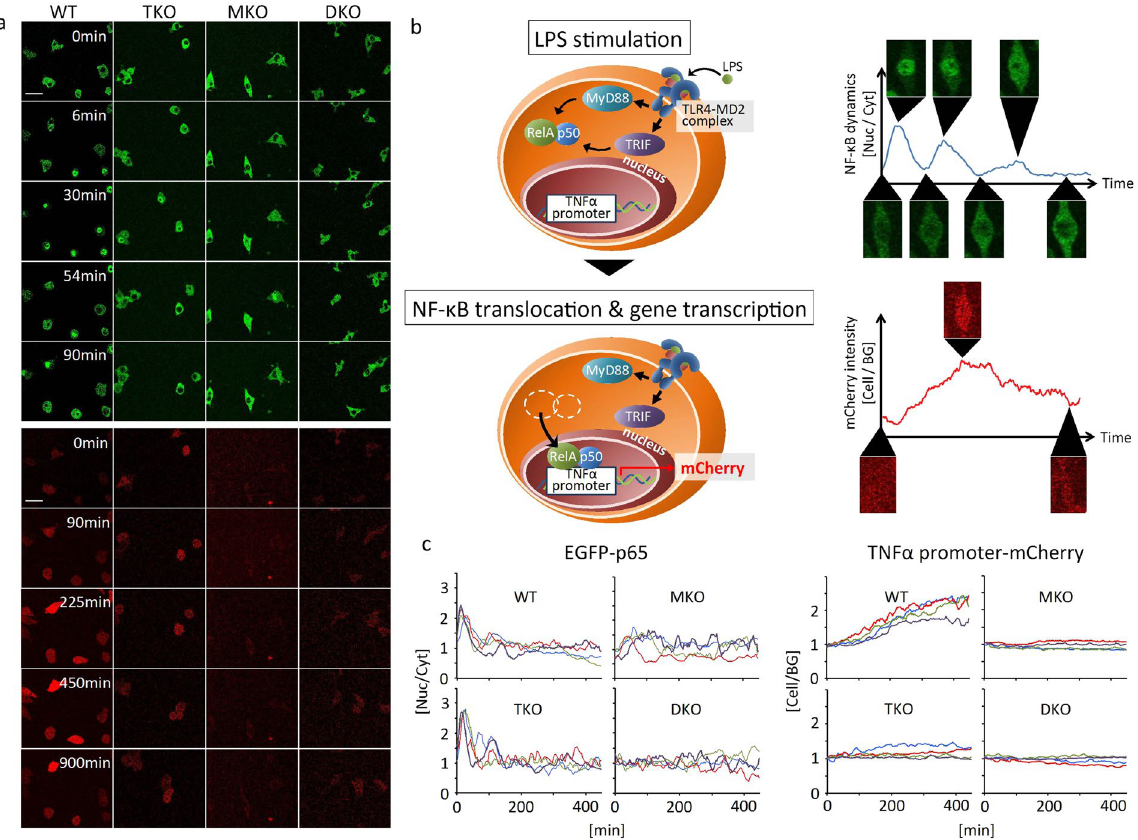
Figure 1. The different roles of MyD88- and TRIF-dependent pathways in LPS-induced NF- κ B nuclear translocation and TNF α promoter activation. ( a ) Live cell imaging of EGFP-tagged NF- κ B nuclear translocation (upper panels) and TNF α promoter-driven mCherry fluorescence (lower panels) in wild-type (WT), TRIF − / − (TKO), MyD88 − / − (MKO), and TRIF − / − /MyD88 − / − (DKO) in response to 500 ng/mL LPS. The scale bar indicates 50 μ m. ( b ) A schematic diagram of TLR4 signaling to NF- κ B and TNF α promoter activation in the reporter cells. TLR4 signal is mediated by MyD88- and TRIF-dependent pathways to activate NF- κ B. The activated NF- κ B translocates into the nucleus where it associates with the TNF α promoter, which induces mCherry gene transcription. ( c ) Time course of the ratio of NF- κ B in the nucleus (Nuc) to those in the cytoplasm (Cyt) (left column), and the ratio of mCherry fluorescence intensity inside a cell (Cell) to those outside (background (BG)) (right column) in the reporter cells. Each figure shows four representatives of approximately 50 cells from four independent experiments. Individual cells are shown by coloured